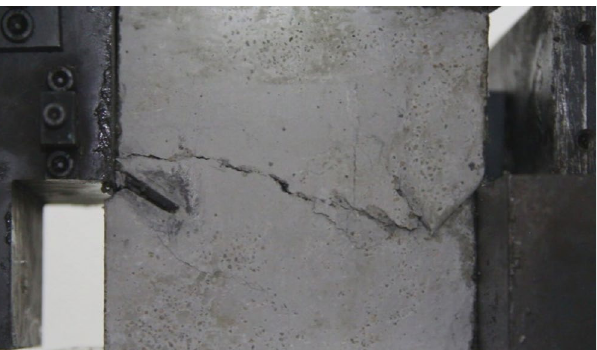
Figure 63. Photograph showing penetration patterns of the left boundary and the tip of the right crack are connected.